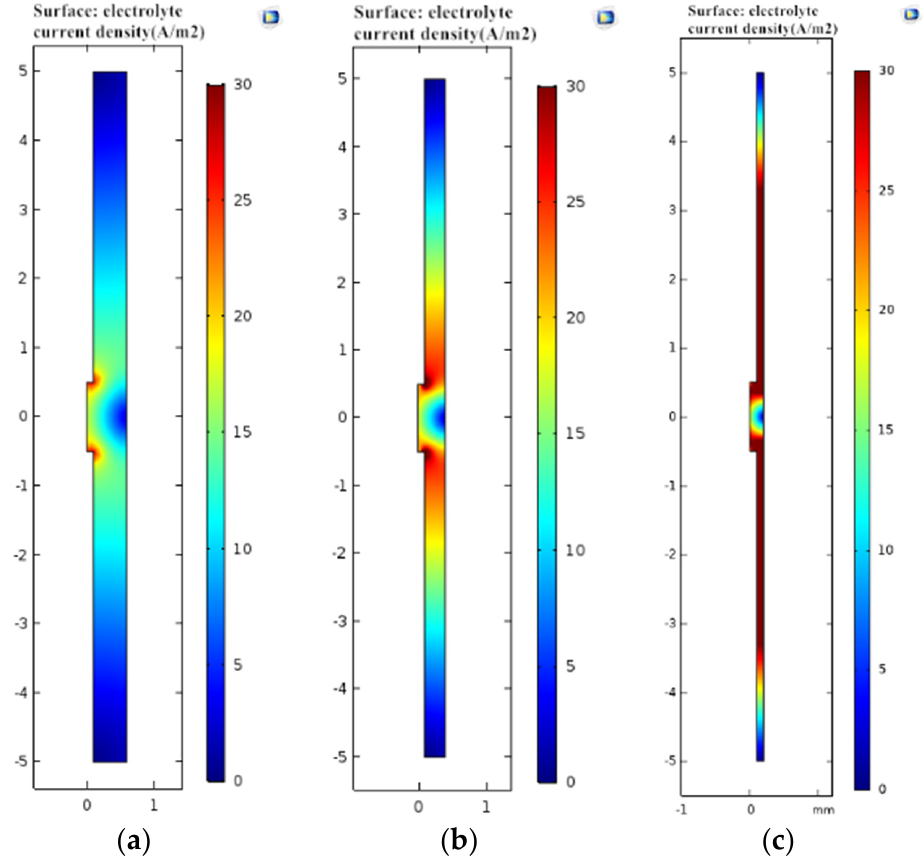
Figure 7. Current density cloud map corresponding to different processing gaps. ( a ) Machining gap 0.5 mm; ( b ) Machining gap 0.2 mm; ( c ) Machining gap 0.1 mm.